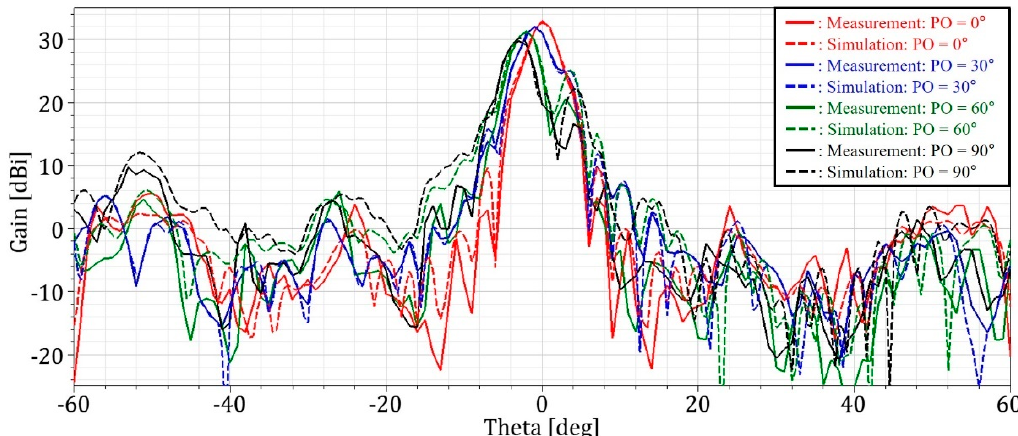
Figure 19. Simulated and measured radiation patterns of 4 × 4 antenna array in the presence of the lens.